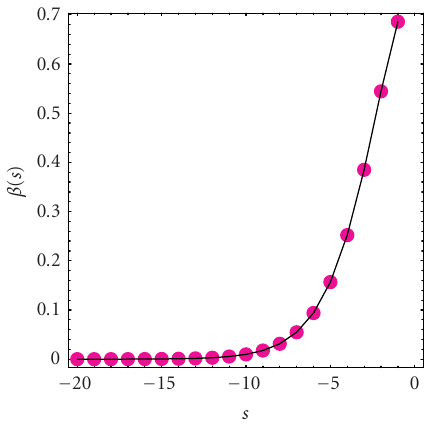
Figure 3.7. The curve β ( s ) runs through the points β − n ( n | 1 /